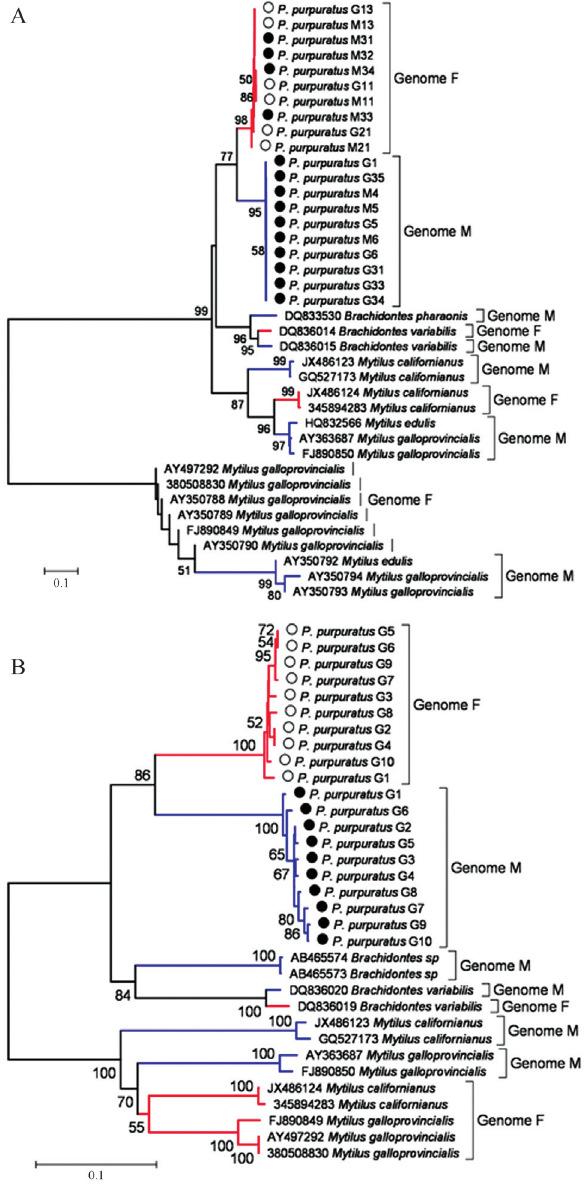
Figure 4 - Neighbour-joining tree for evolutionary relationships of the F and M genomes of P. purpuratus and other species of Mytilus , based on (A) the mitochondrial gene 16S and (B) gene COI genome . M: mantle tis- sue; G: gonadal